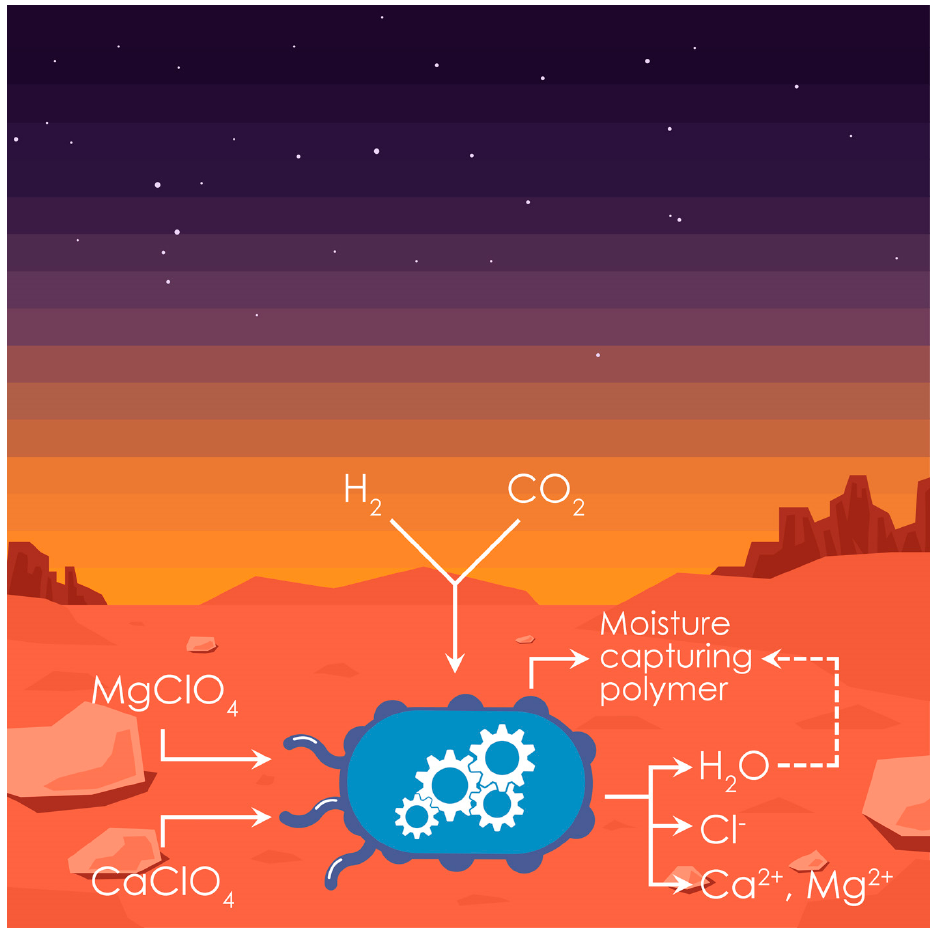
Figure 2. Engineering microorganisms to facilitate plant life on Mars. This conceptual microbe scavenges atmospheric hydrogen (H 2 ) and carbon dioxide (CO 2 ), and it is customized to condition Martian soil for plant growth by reducing soil perchlorate salts (MgClO 4 and CaClO 4 ) and increasing soil moisture. H 2 O: water; Cl − : chlorine; Ca 2+ : calcium; and Mg 2+ : magnesium.